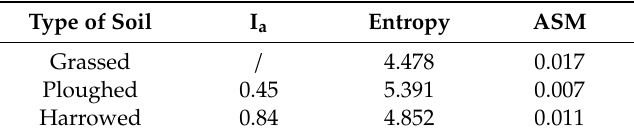
Table 4. Values of I a (laser profilometer), entropy and ASM light drone areas for the 3 types of soil (plowed, harrowed and grassed). Type of Soil I a